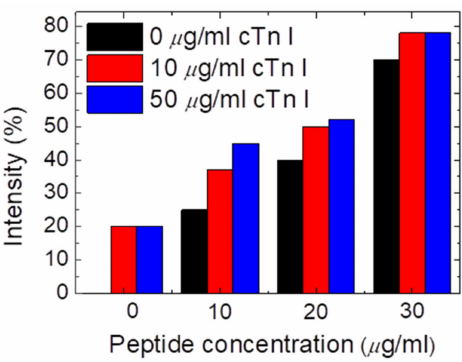
Figure 6. Intensity of an immunoassay CLC chip immobilized with peptide (concentration range from 0 to 30 µ g/mL) and cTnI (concentration range from 0 to 50 µ